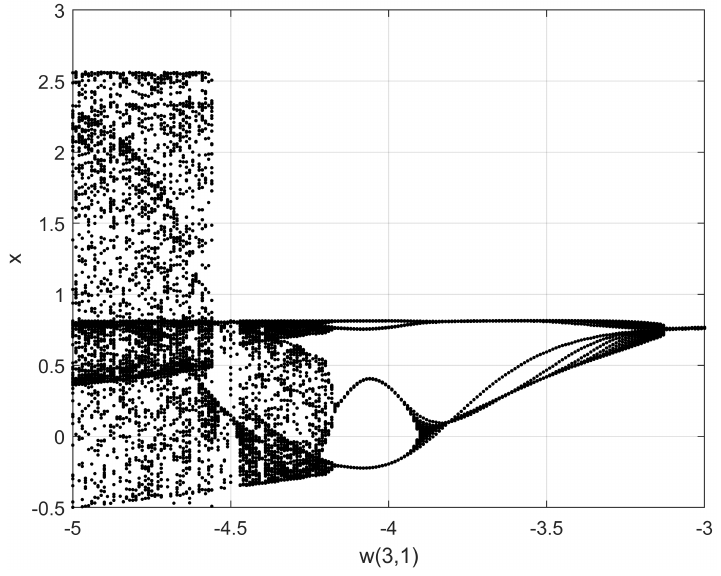
Figure 5. Bifurcation diagram varying W ( 3,1 ) in the range given in Table